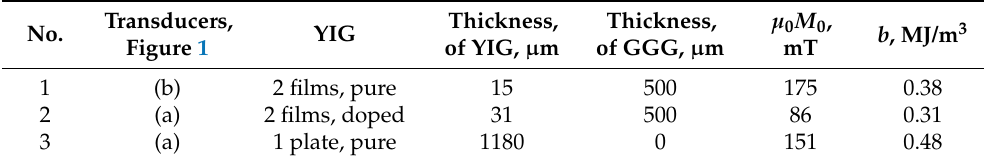
Table 1. Properties of the devices and model fitting